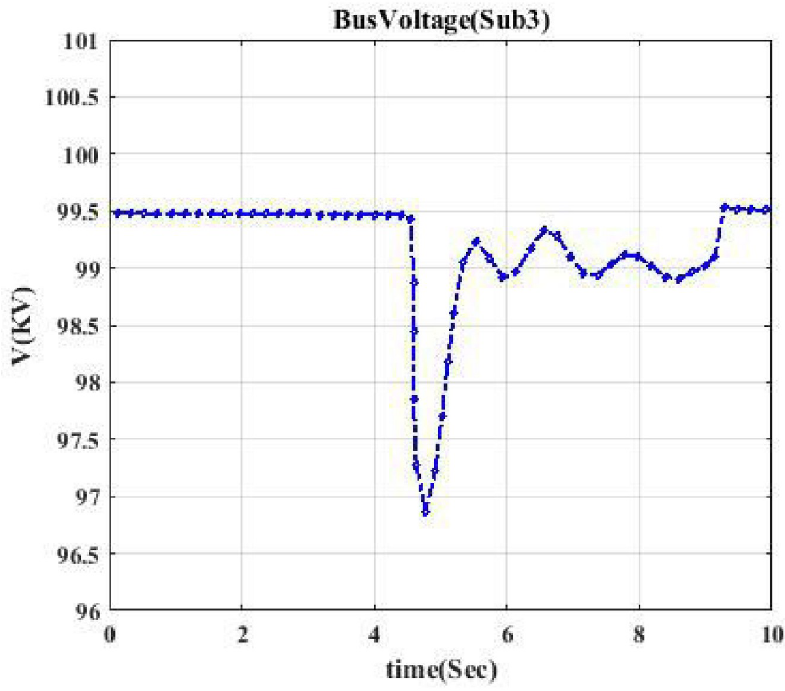
Fig 7. Voltage profile related to switching Sub3-S1. This shows the voltage curve when switch S1 is switched.